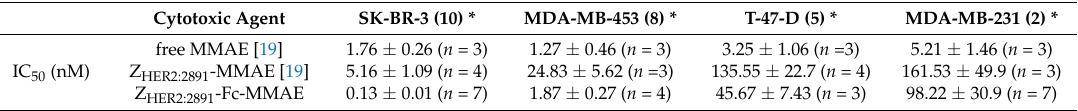
Table 1. The cytotoxicity of Z HER2:2891 -Fc-MMAE in comparison to the previously published IC 50 values obtained for the Z HER2:2891 -MMAE conjugate. IC 50 results are expressed as mean ± SEM. Cytotoxic Agent